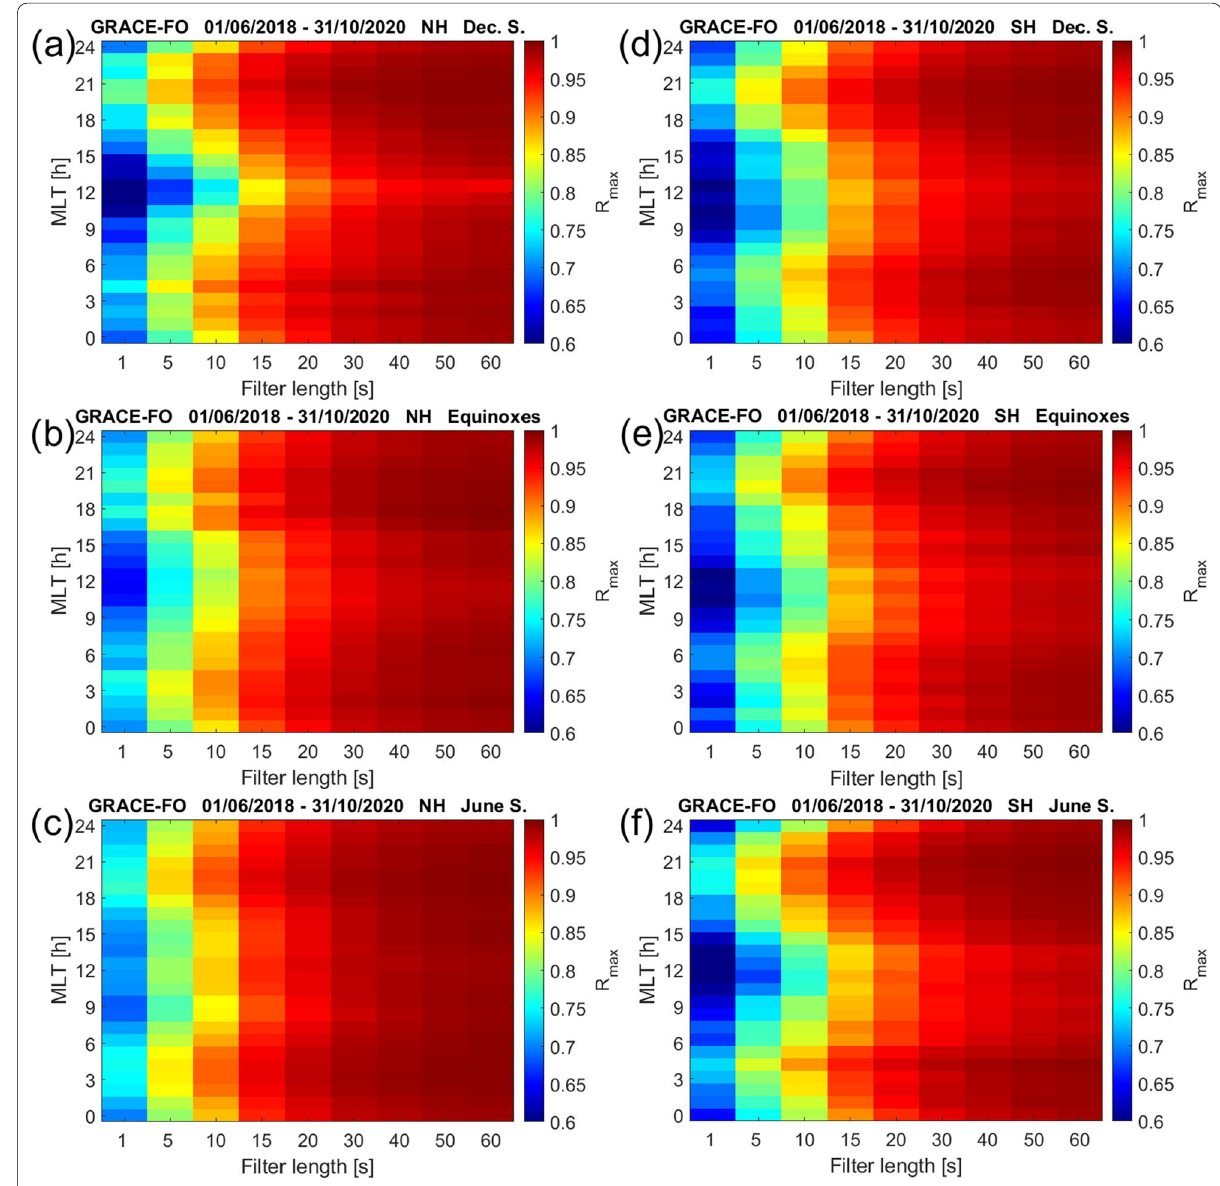
Fig. 10 Distribution of R max as a function of MLT and filter lengths, separately for three seasons and two